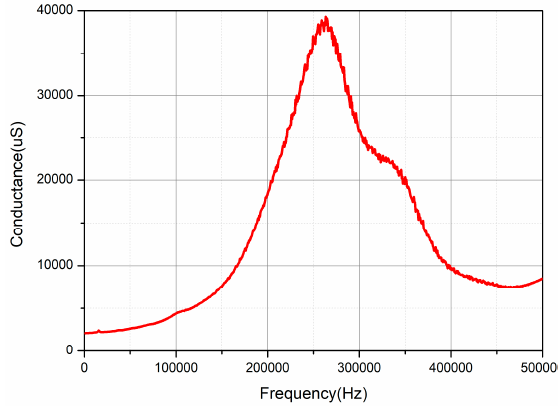
Figure 13. The conductance curve of transducer in the water.